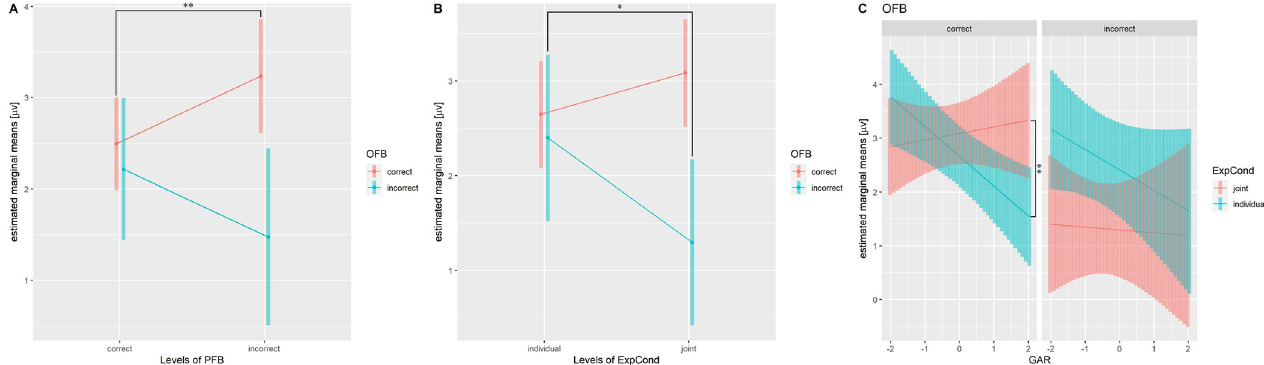
Fig 5. Estimated marginal means of FRN/RewP. (A) Interaction of OFB and PFB. (B) Interaction of OFB and ExpCond. (C) Interaction of OFB, ExpCond, and GAR. � p < 0.05, �� p <